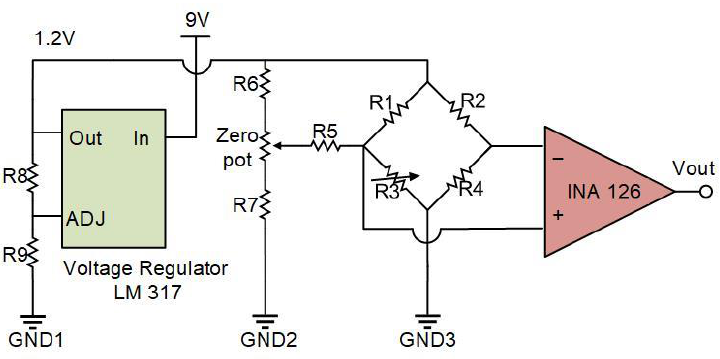
Figure 10. Diagram of the circuit box that interfaces with the sensor and amplifies the output